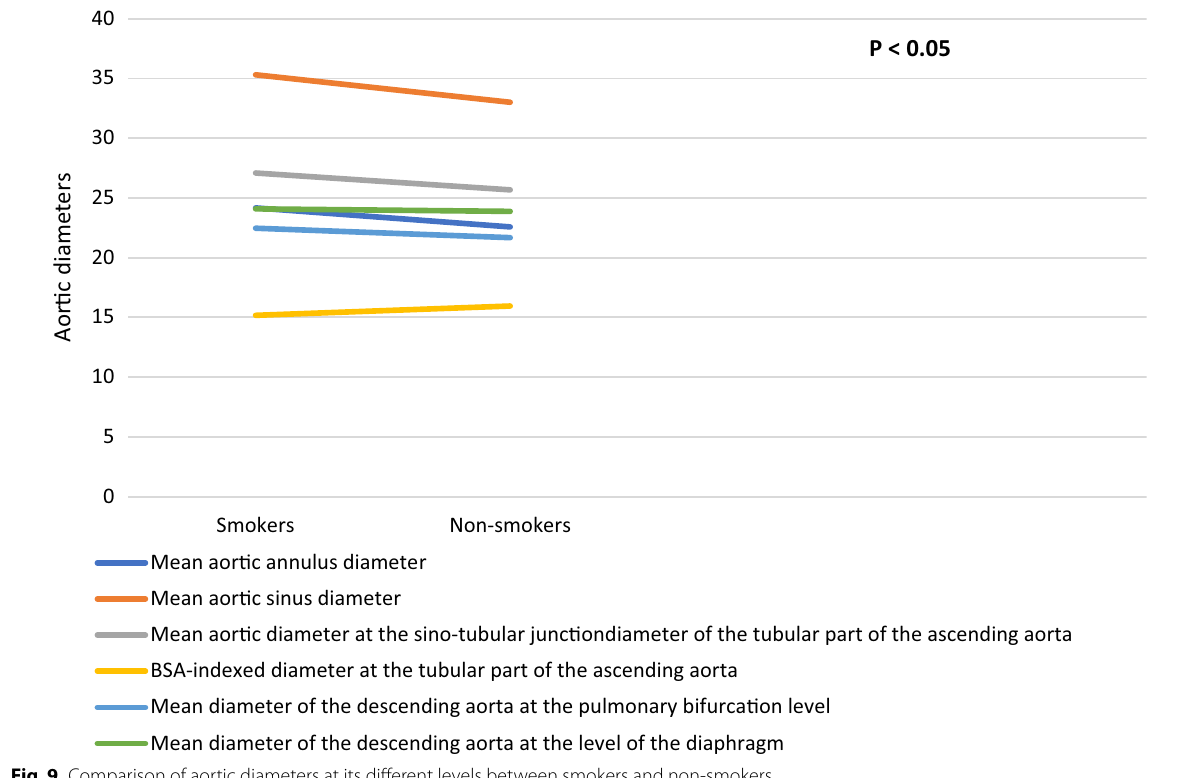
Fig. 9 Comparison of aortic diameters at its different levels between smokers and